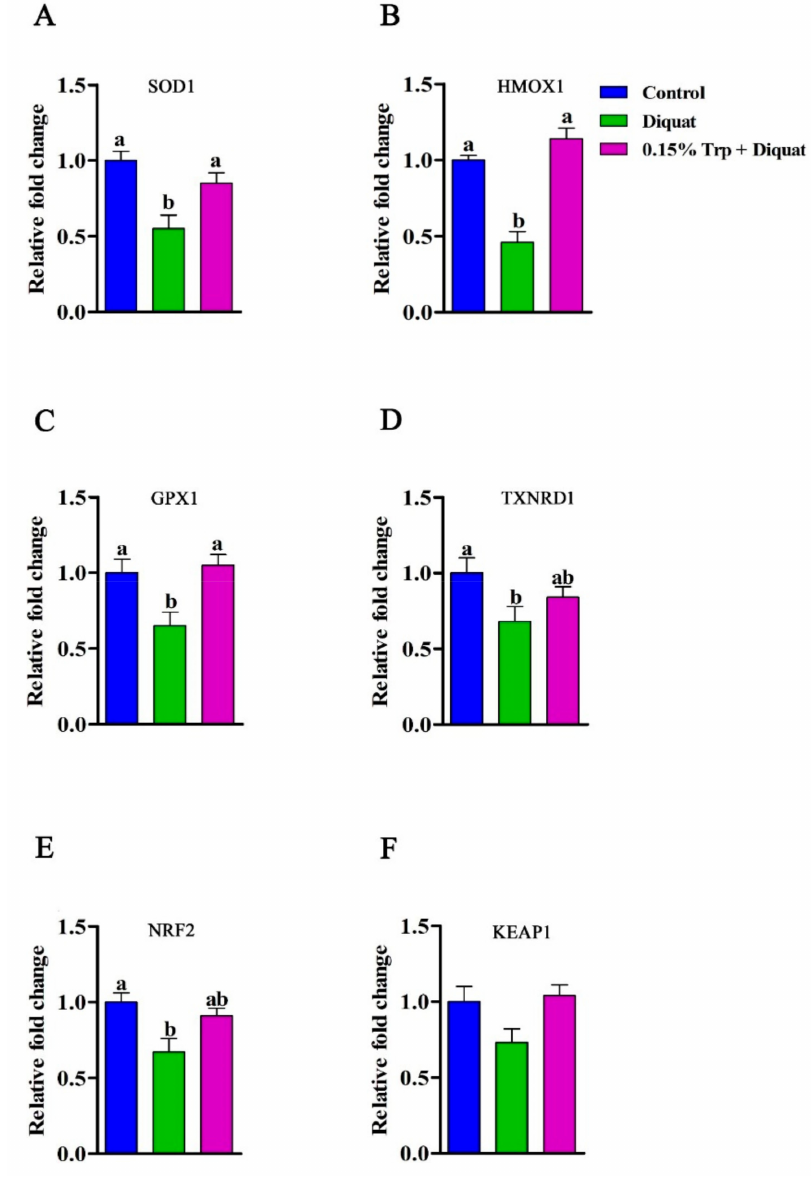
Figure 5. E ff ects of dietary tryptophan supplementation on mRNA expression of redox sensitive genes in piglets challenged with diquat. ( A ) SOD1 , copper / zinc superoxide dismutase; ( B ) HMOX1 , heme oxygenase 1; ( C ) GPX1 , glutathione peroxidase; ( D ) TXNRD1 , thioredoxin reductase; ( E ) NRF2 , nuclear respiratory factor 2; ( F ) KEAP1 , kelch like ECH associated protein 1. Data are means ± standard error; n = 8 for each group. Mean values sharing di ff erent superscripts within the same row di ff er significantly ( p < 0.05). Control, piglets fed the basal diet without diquat injection; diquat, piglets fed the basal diet and challenged with diquat; 0.15% Trp + diquat, piglets fed the 0.15% supplemented diet and treated with